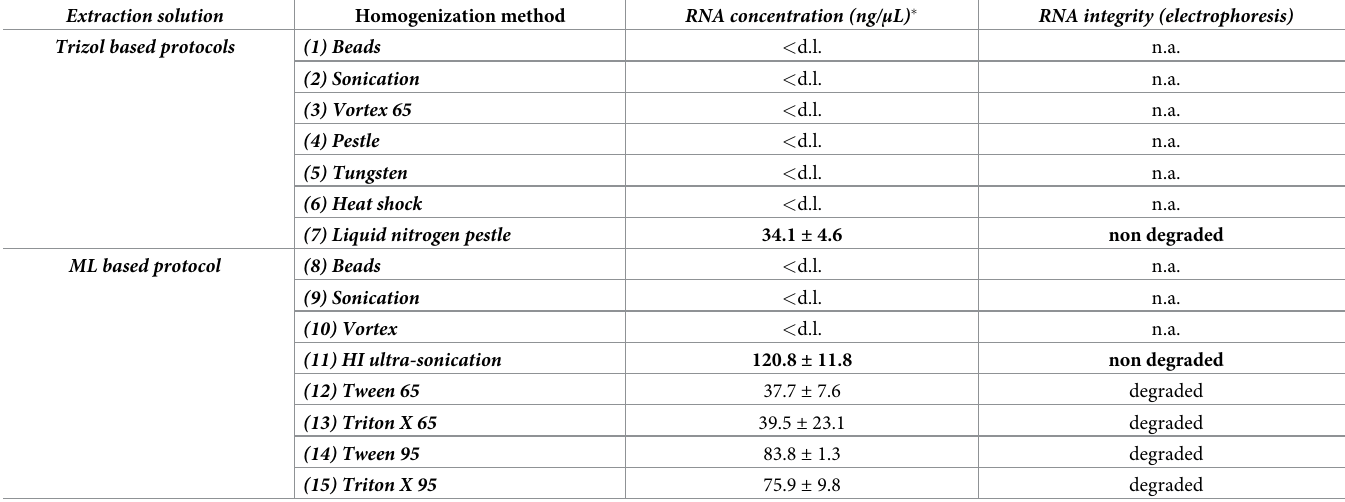
Table 3. Mean RNA concentration ( ± standard deviation; n = 2) for the different homogenization methods tested for Planktothrix agardhii PCC 7805. RNA integ- rity (non degraded/degraded) is indicated. � for 50 mL of culture at an OD 750nm = 0.3 recovered in 50 μ L RNAse/DNAse free sterile water; n.a.: non-available. Detection limit (d.l.) was 1.6ng/ μ